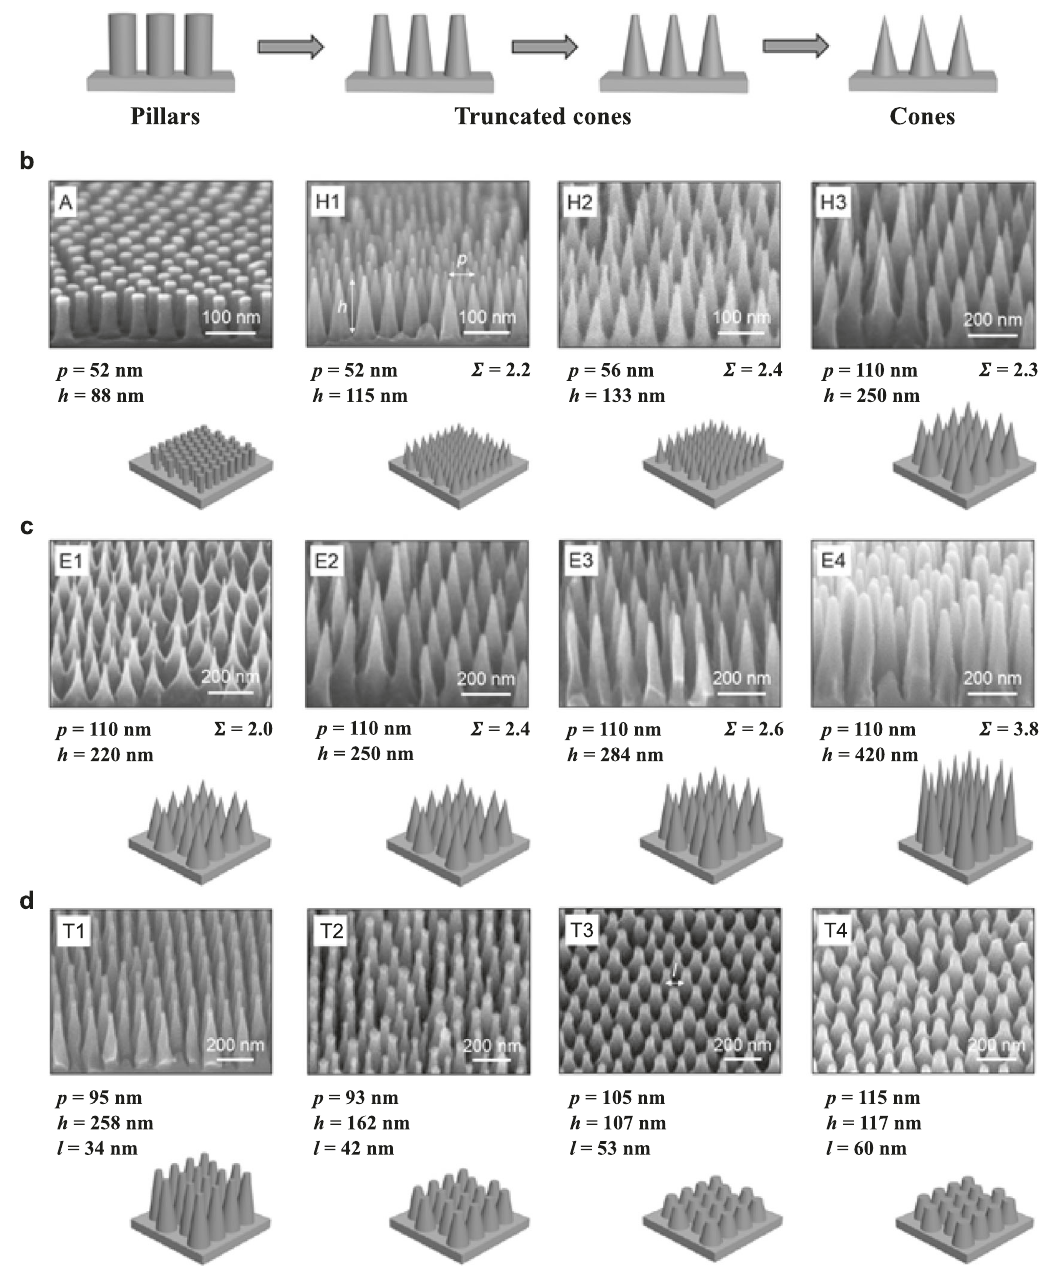
Fig. 1 Families of samples. a Schematic illustrating the geometry transition from nanopillar, to truncated cone and fi nally, to sharp cone. b – d Scanning electron microscopy (SEM) images and schematics corresponding to the three families of nanocones. For all surfaces, the cones with height h , pitch p , apex angle β and sharpness Σ = 1/ β are arranged on a dense hexagonal array and coated by a hydrophobic layer. b . A is a reference sample made of nanopillars with diameter l = 30 nm. H1 is the smallest nanoconical texture, H2 and H3 are homothetic (constant h / p ), with a size ratio of 1.1 and 2.1, respectively. c E1, E2, E3 and E4 are of equal pitch p = 110 nm and gradually extruded from E1 with h = 144 nm by a factor of 1.7, 2.0 and 2.9, respectively. Families H and E intersect: H3 and E2 are the same material. d T1, T2, T3 and T4 have the same pitch but are truncated, with various top diameters l